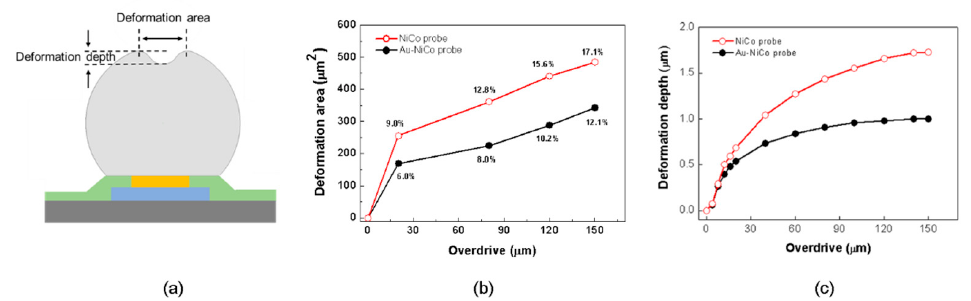
Figure 8. ( a ) Schematic drawing of the deformation area and deformation depth caused by the probe contact. ( b ) Deformation area and deformation ratio of the solder ball with increasing overdrive. ( c ) Depth of deformation in the solder ball with increasing overdrive.